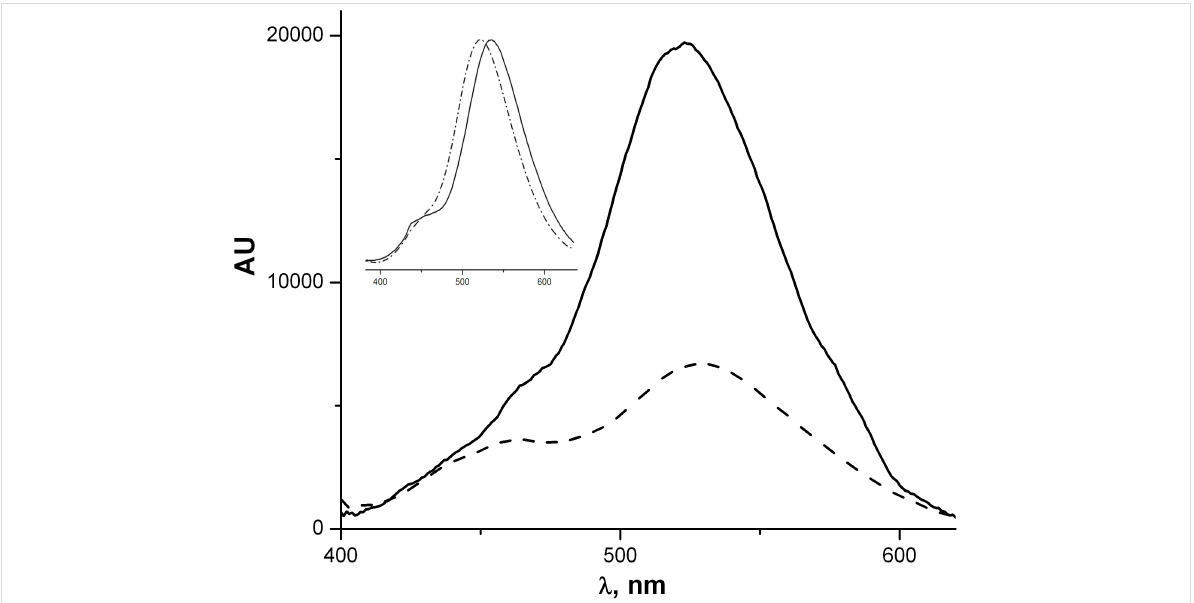
Figure 7: Fluorescence spectra of 4 ethanol (5 × 10 − 5 M) (dashed curve) before and after the addition of ZnO NPs (solid curve). Excitation wave- length: 325 nm. The inset shows the same normalized